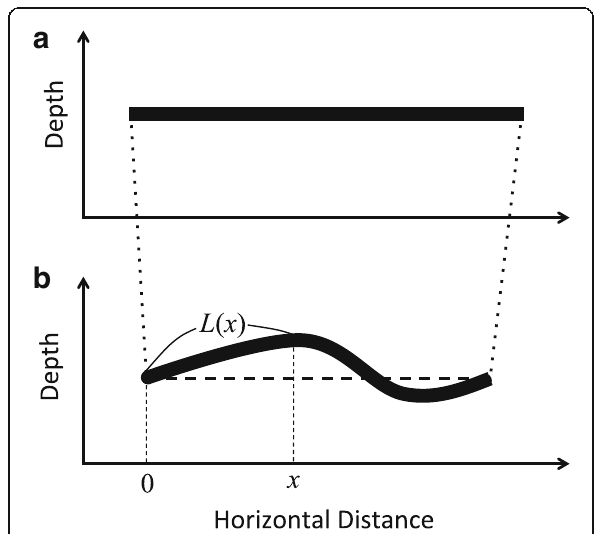
Fig. 4 Schematic illustration of the measurement of the slab contraction amount. a Configuration of the slab prior to subduction, which should be flat. b Configuration of the slab after subduction. Slab deformation proceeds during subduction. The contraction amount of the slab is calculated by L ( x ) − x , where x is the horizontal distance measured from the origin and L ( x ) is the length of the thick solid curve, which represents the slab